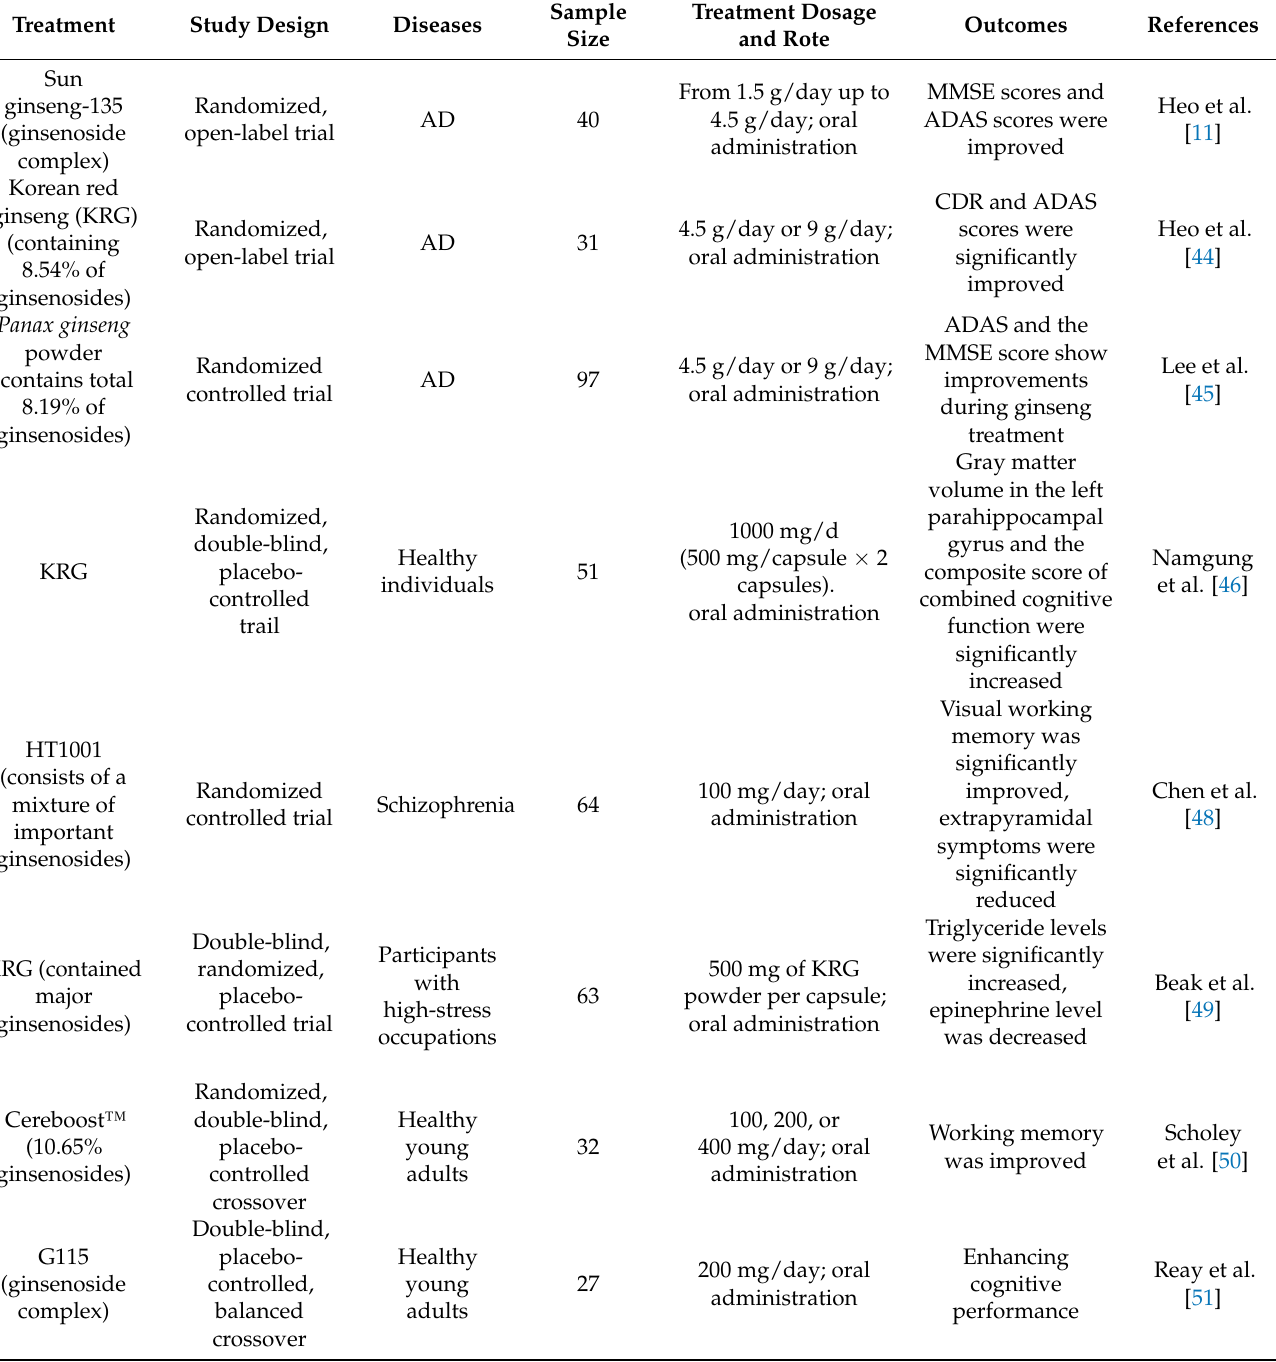
Table 2. Clinical trials of ginseng or ginsenosides in improving